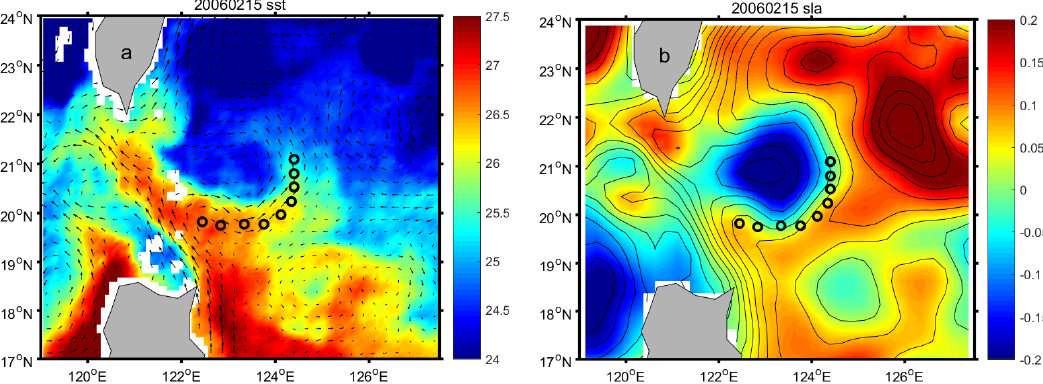
Figure 2. Snapshot of ( a ) SST (color, ◦ C) and geostrophic velocity (vectors); ( b ) SLA (color, in m) and ADT contours on 15 February 2006. Warm filaments are marked by small circles near the center of the frame accompanied by a cyclonic